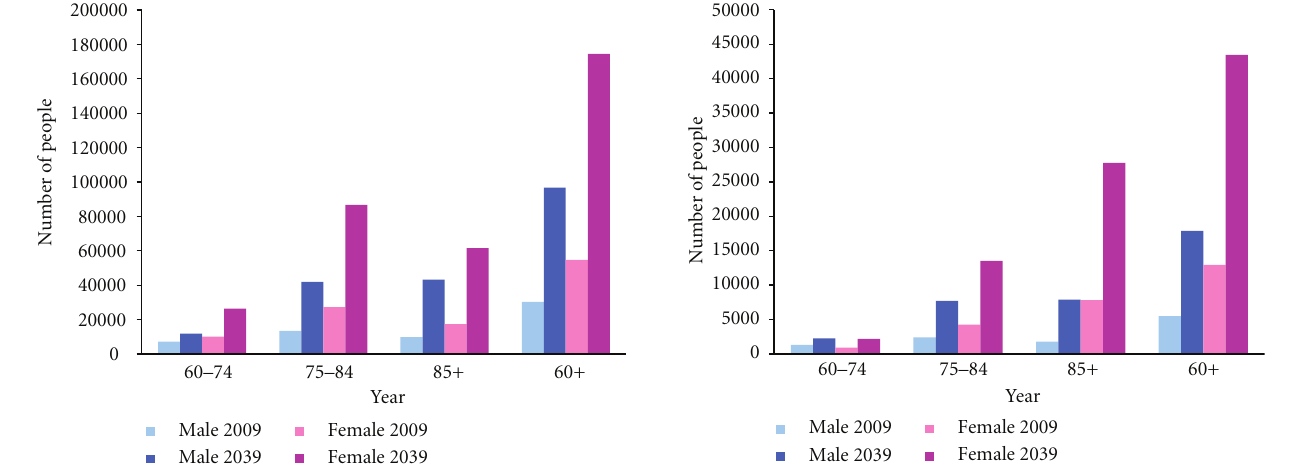
Figure 1: Estimated and projected numbers of people living in community with dementia in Hong Kong, by age group and sex, 2009 and 2039. Data sources: authors’ calculations based on data from elderly commission of Hong Kong [7] Lam et al. [8], and Census and Statistics Department of Hong Kong [3].